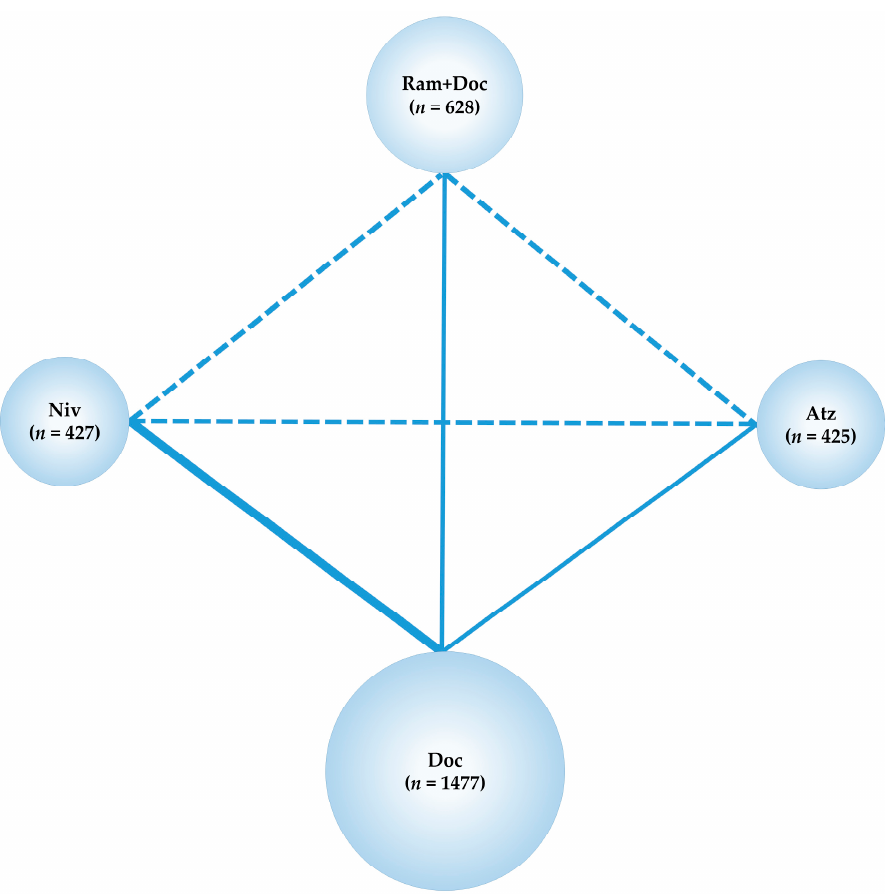
Figure 2. Network map. Solid lines represent randomized controlled trials (RCTs) while relative thickness represents the number of included studies. The dashed line reveals the absence of RCTs, suggesting that an indirect treatment comparison could be attempted. Circle size reflects the proportion of patients included in each treatment group. Ram+Doc (ramucirumab plus docetaxel); Niv (nivolumab); Atz (atezolizumab); n , number of patients.